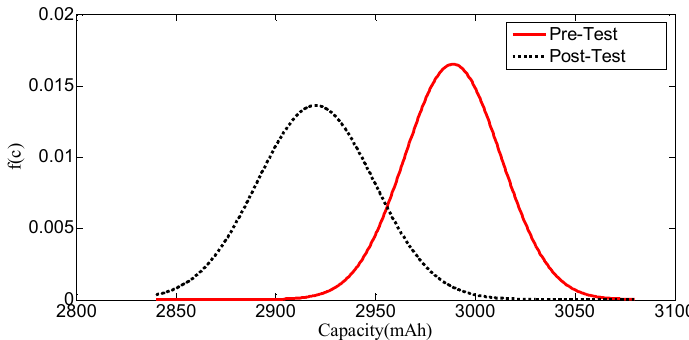
Figure 9. The distribution function and theoretical normal distribution function of the capacity samples after vibration.